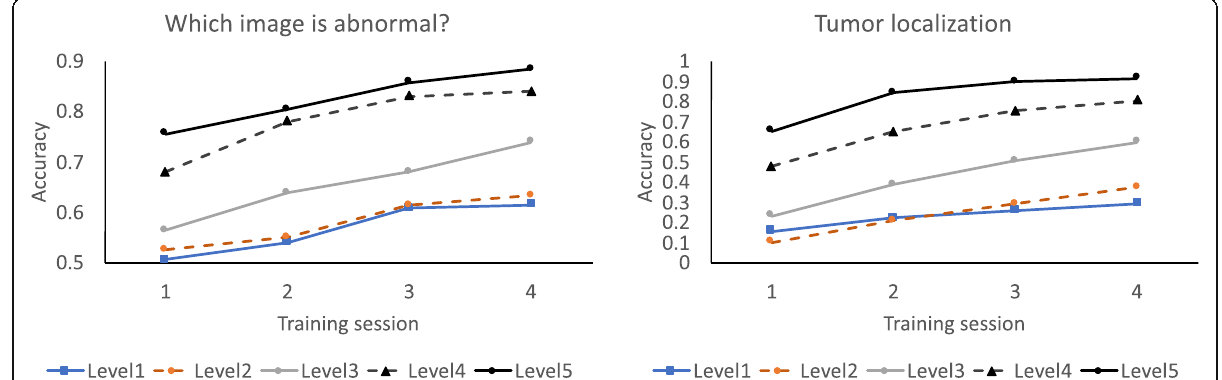
Fig. 4 Training performance for displays containing tumors of different subtlety levels. Level 1 is the most subtle, and level 5 is the most obvious. Data were the average of all 60